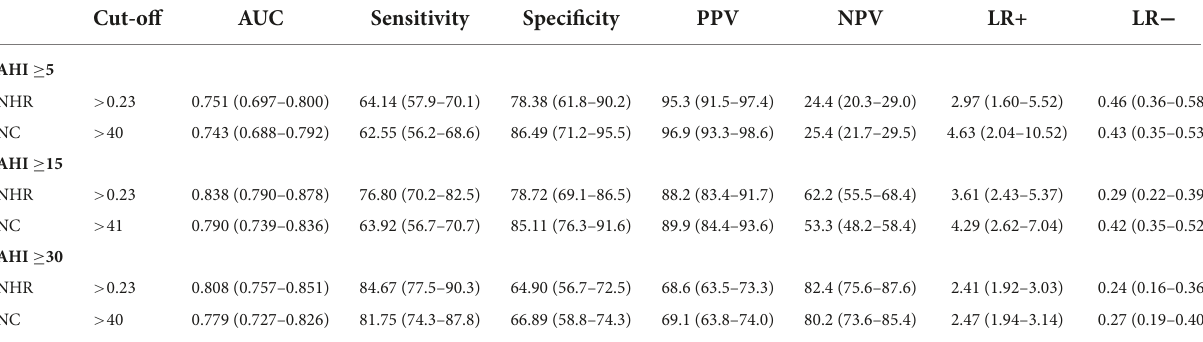
TABLE 4 Screening capacity of neck-to-height ratio (NHR) and neck circumference (NC) at different apnea-hypopnea index (AHI) thresholds. Cut-off AUC Sensitivity